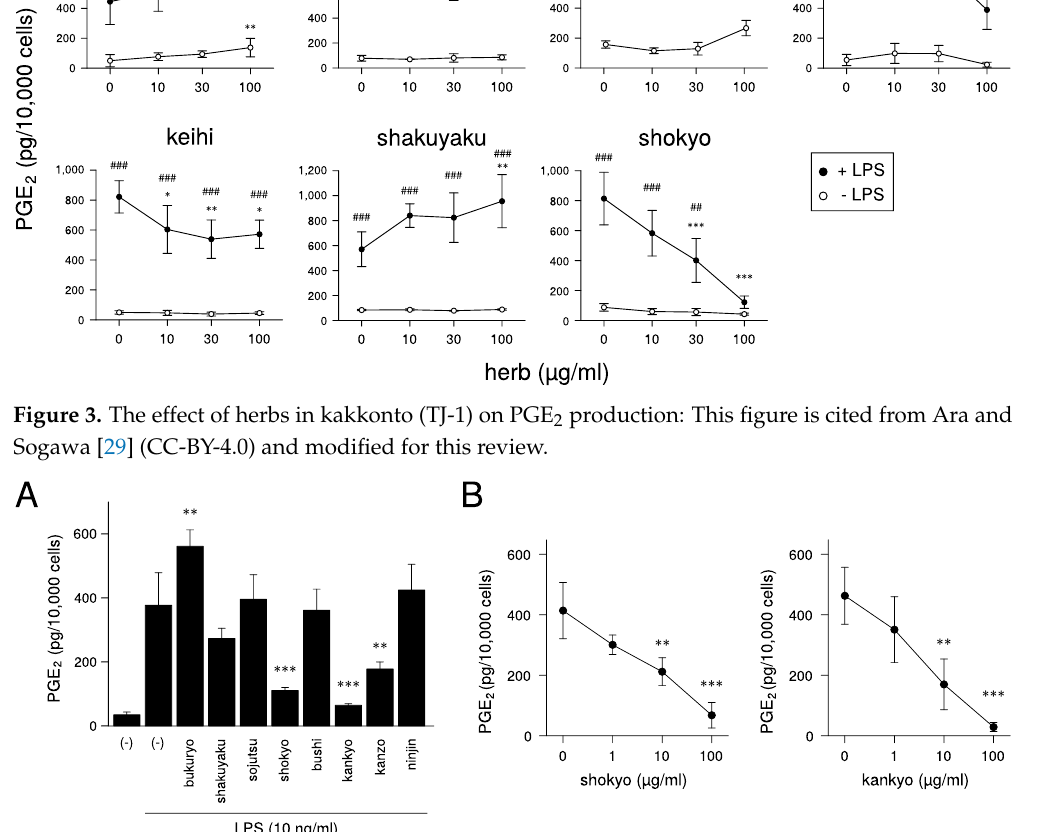
Figure 4. The effect of herbs in shinbuto (TJ-30) and ninjinto (TJ-32) on PGE 2 production: This figure is cited from Ara and Sogawa [39] (CC-BY-4.0) and modified for this review. ( A ): Effect of each herb, ( B ): Concentration-dependent effects of shokyo and